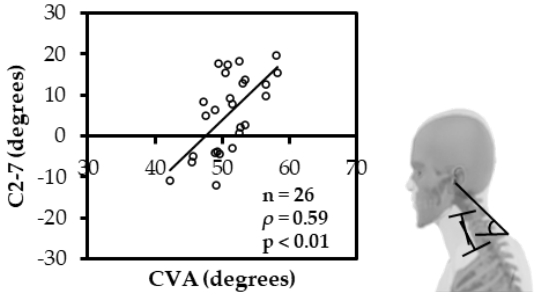
Figure 4. Spearman rank correlation between CVA and C2-7. The CVA and C2-7 had a significant positive correlation. (CVA: cranial vertical angle; C2-7: cervical lordosis).